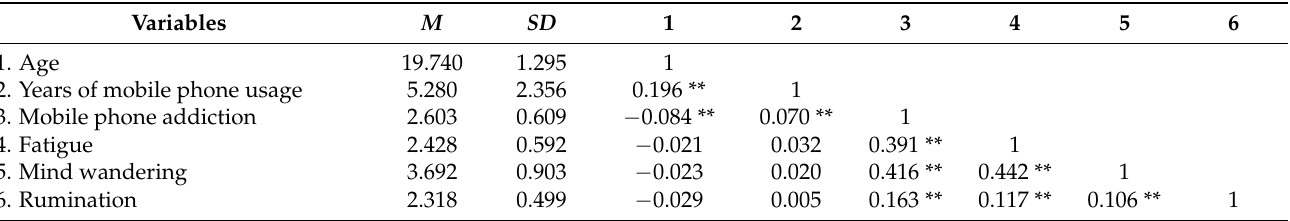
Table 1. Descriptive statistics and interrelations among some of the observed